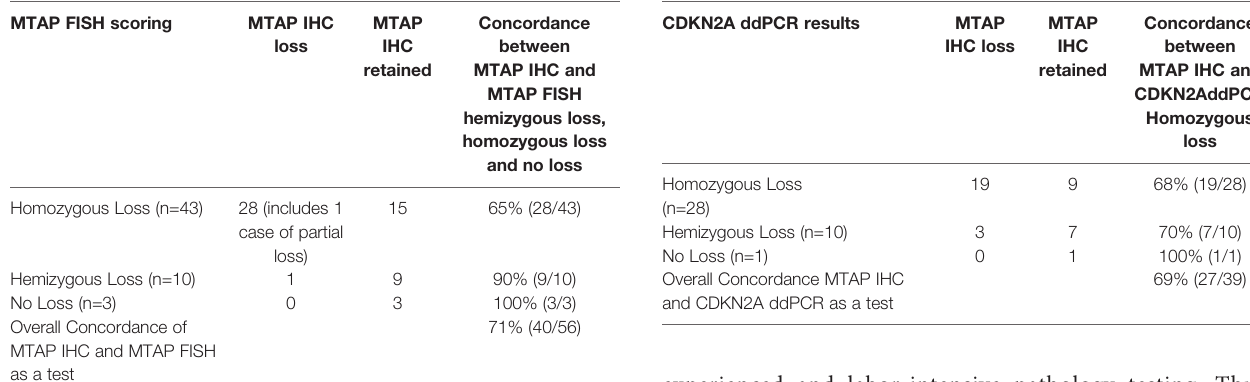
TABLE 9A | Comparison of methylthioadenosine phosphorylase (MTAP) immunohistochemistry (IHC) and MTAP fl uorescence in situ hybridization (FISH) homozygous and hemizygous deletion, and no loss (retention).